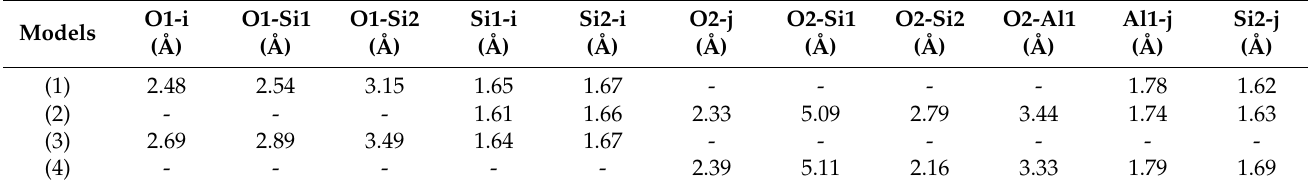
Table 3. The distances between the oxygen from water, Si, Al, and oxo-bridging in the transition states (B) as shown in Figures